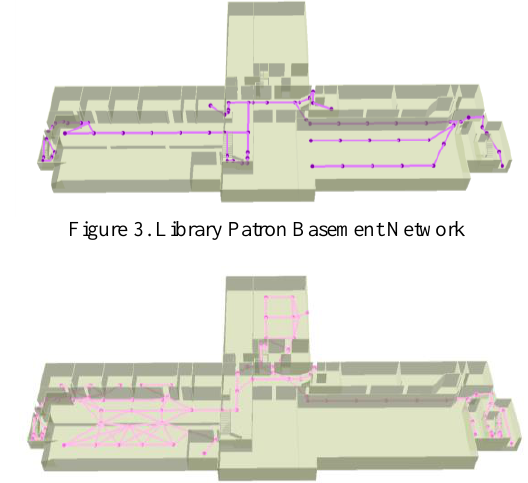
Figure 4. Library Staff Basement Network